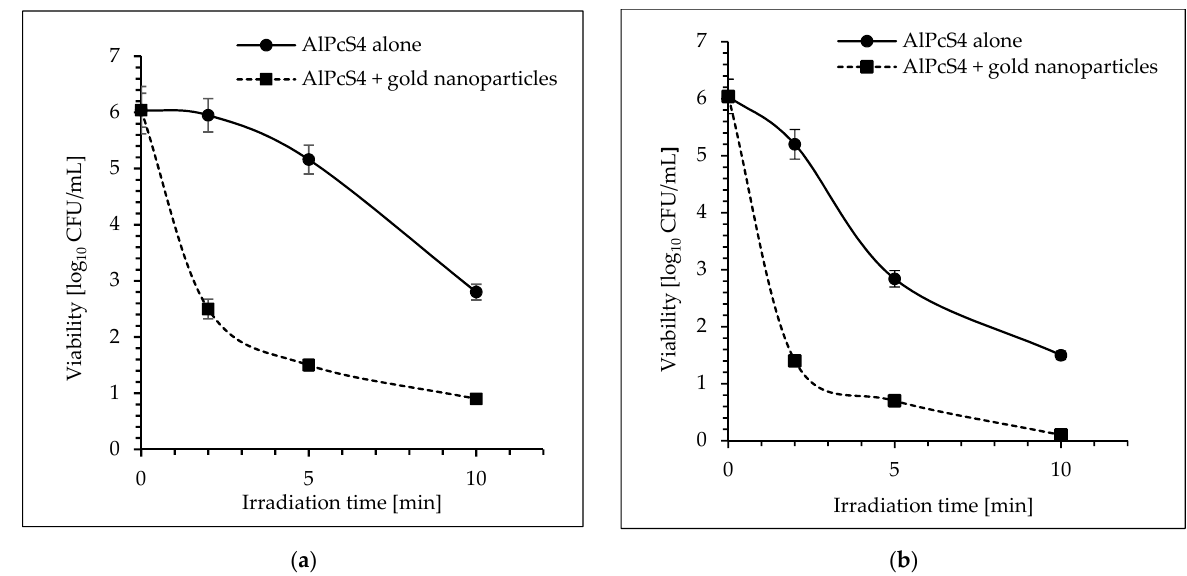
Figure 5. The effect of gold nanoparticles on the effectiveness of photo-killing of S. aureus with AlPcS 4 as a photosensitizer. ( a ) laser light ( λ = 650 nm; the radiation power density of 105 mW cm − 2 ); ( b ) laser light ( λ = 650 nm; the radiation power density of 210 mW cm − 2 ). Average SD of three independent experiments is shown. The efficiency of this treatment was considered as statistically significant for all groups ( p < 0.05).